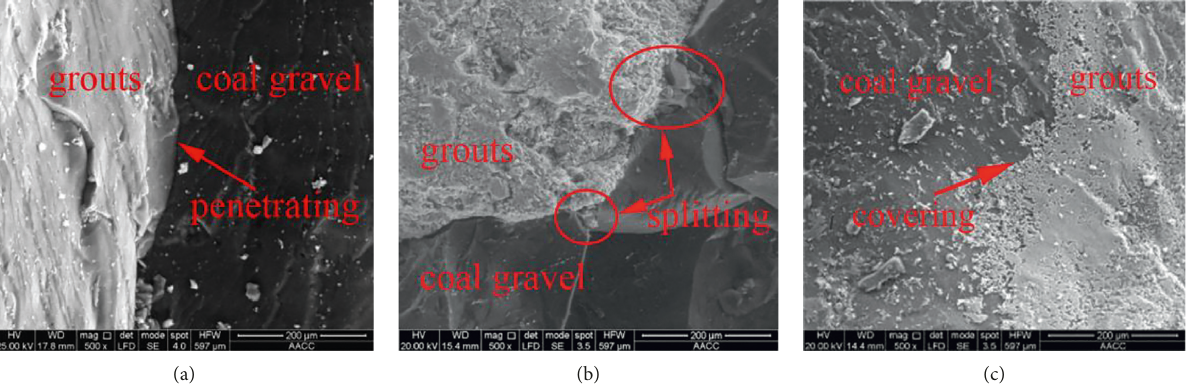
Figure 12: Three microscopic diffusion modes for the grouts flowing in most of the grouted crushed coal specimens obtained from the SEM images (magnified in the scale of 1:500) of failure surfaces. (a) Small specimen: grouts penetrating into the voids around the coal gravels (filling). (b) Large specimen: splitting the coal gravels first and then penetrating into them. (c) Small or large specimen: covering the coal